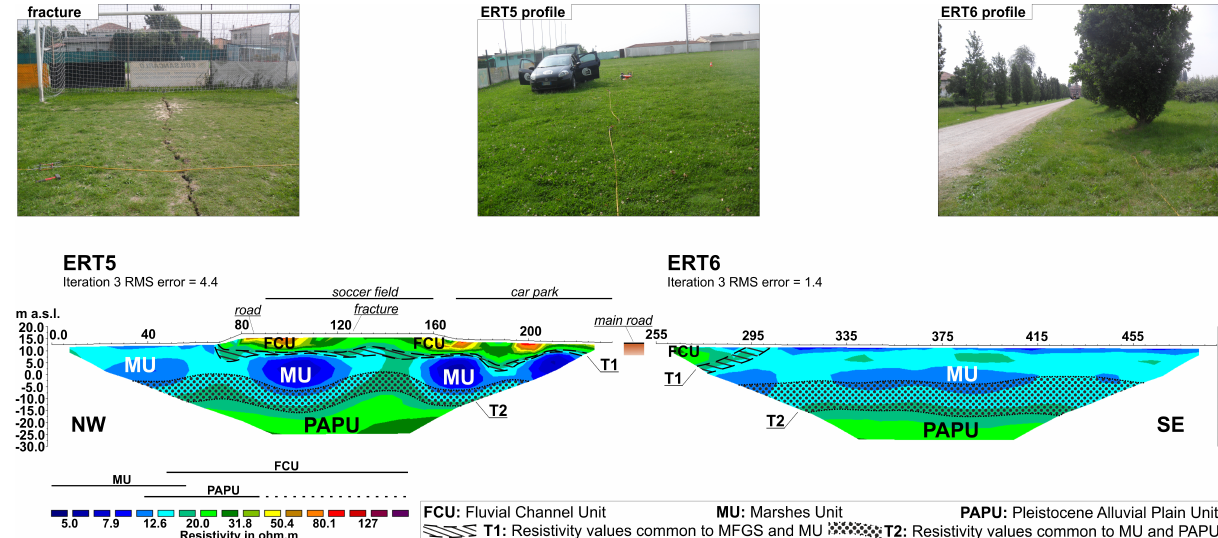
Fig. 5. ERT5 and ERT6 carried out in Mirabello (see Fig. 1c for the location of